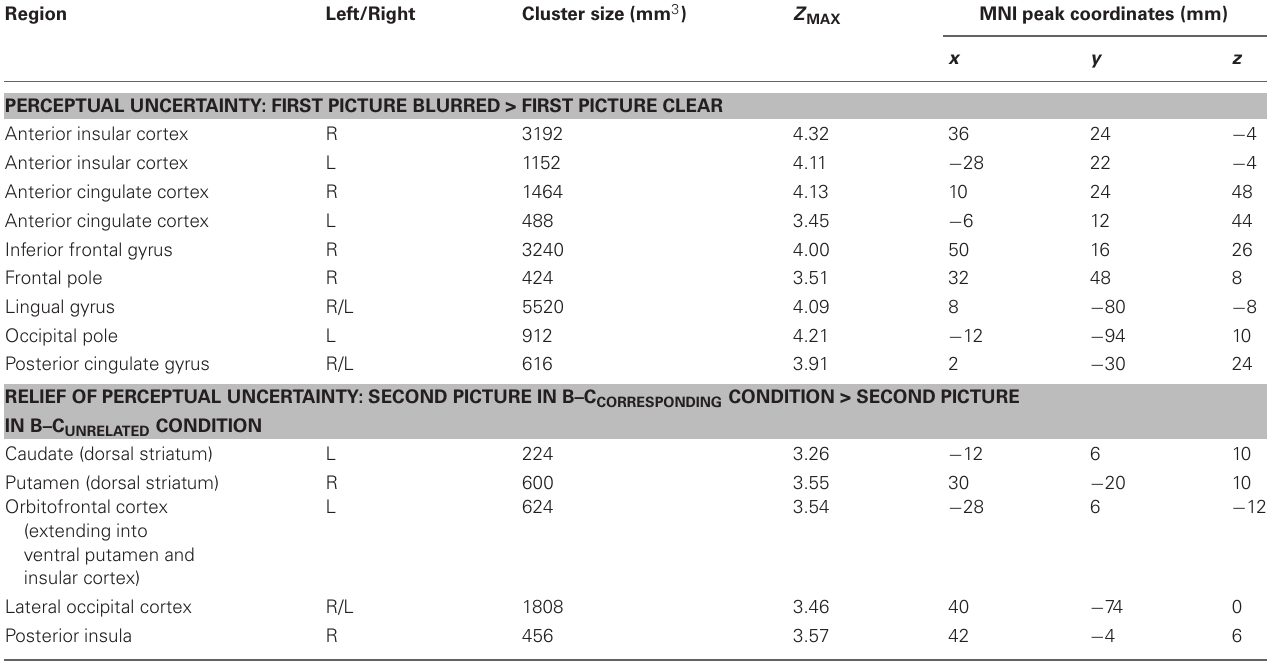
Table 3 | All brain regions that were activated in response to perceptual uncertainty (upper part) and in response to the relief of uncertainty (lower